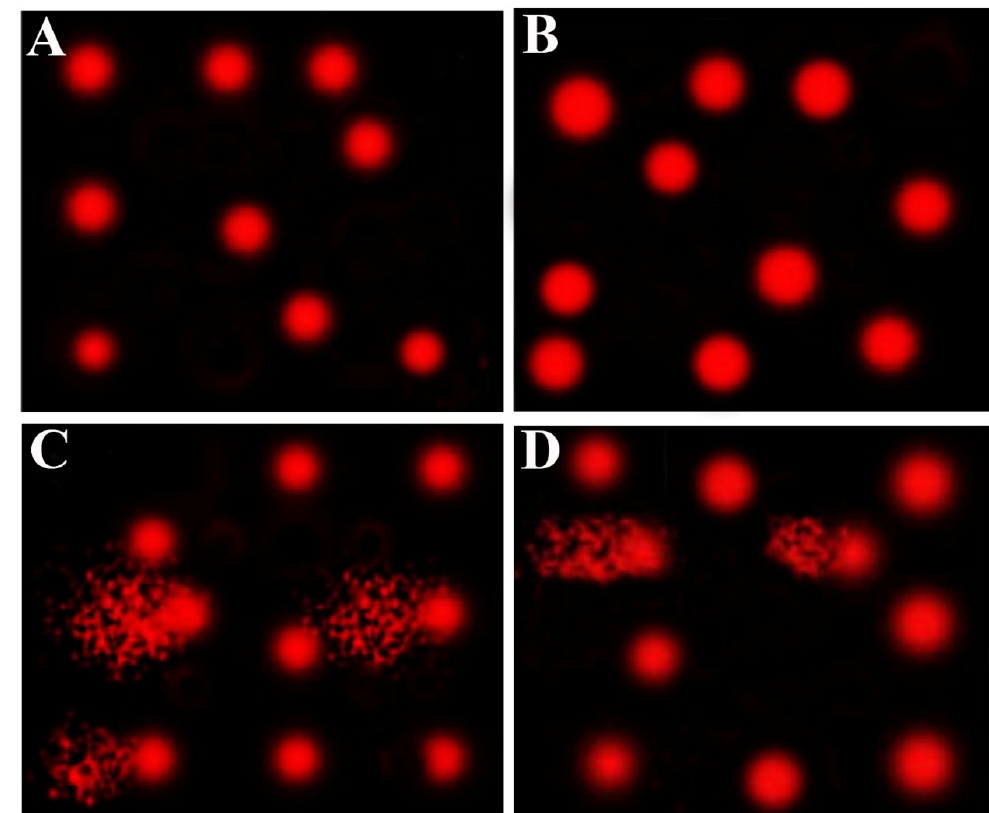
Figure 3. Representative comet assay images show the influence of treatment with AvS and/or CsA on hepatic cells’ DNA damage. The assay was carried out in 3 independent experiments. ( A ) Cnt, ( B ) AvS, ( C ) CsA, ( D ) AvS + CsA. In ( C , D ), the fragmented patches refer to the comet tail which contains degraded DNA, while the front red circle refers to the intact DNA.